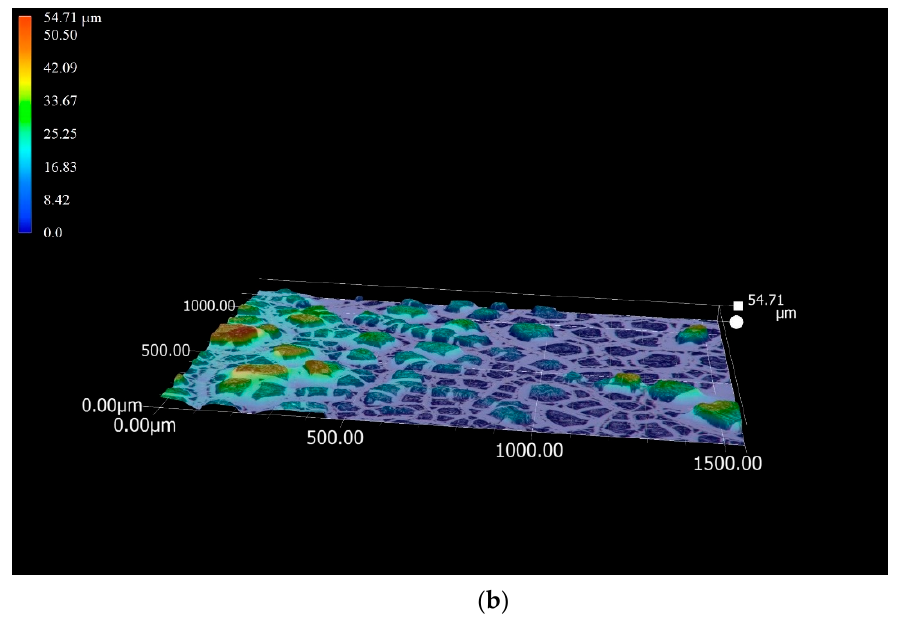
Figure 1. ( a ) Microscopic images (3000×) and ( b ) 3D image (200×) of a Pd precipitate reduced at Pd(II):HCOOH (1:2) ratio at 50 °C.